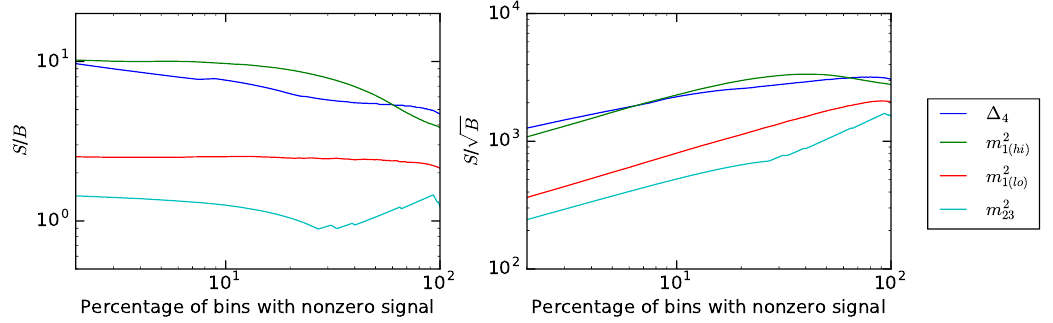
Figure 12 . Performance curves for (cid:1) 4 and the m 2 variables using the S = B and S = p B